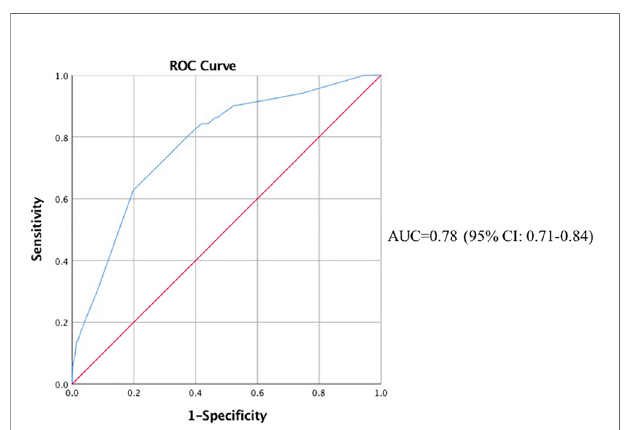
FIGURE 2 | ROC Curve of the Multivariable Analysis of Organ/Space Surgical Site Infection. ROC, receiver operating characteristic; AUC, area under the curve; CI, con fi dence